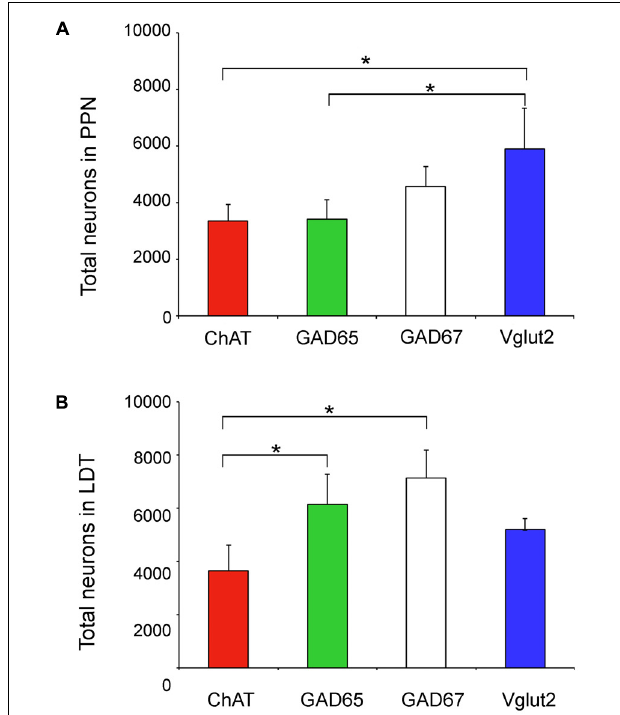
FIGURE 5 | Total number of neurons of the four phenotypes analyzed in the PPN and LDT. (A) Graph showing the mean total number of neurons in the PPN. The estimated number of Vglut2-positive cells was significantly higher than that of GAD65- and ChAT-positive subpopulations (Kruskal Wallis, p = 0.0003). (B) Parallel data in the LDT; here the estimated total number of ChAT-positive neurons was significantly lower than that of GAD65 and GAD67 subpopulations (Kruskal Wallis, p = 0.0004). Asterisks indicate statistically significant differences among